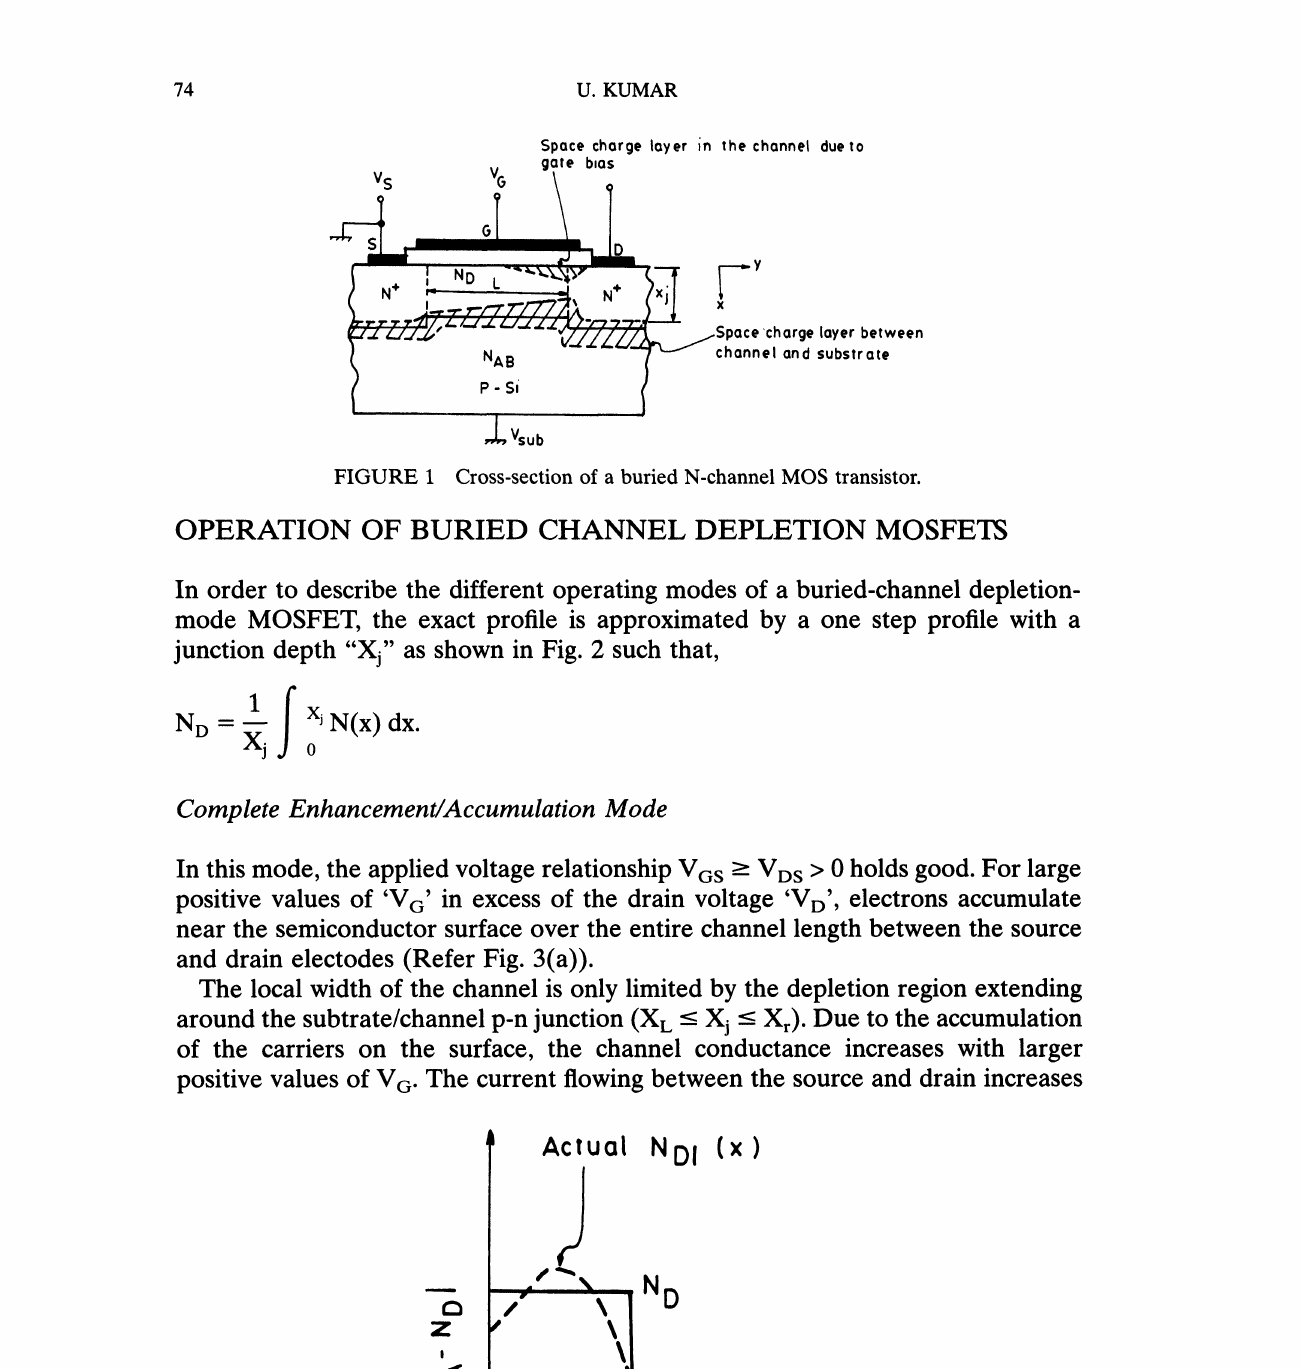
FIGURE 2 Actual profile and one-step